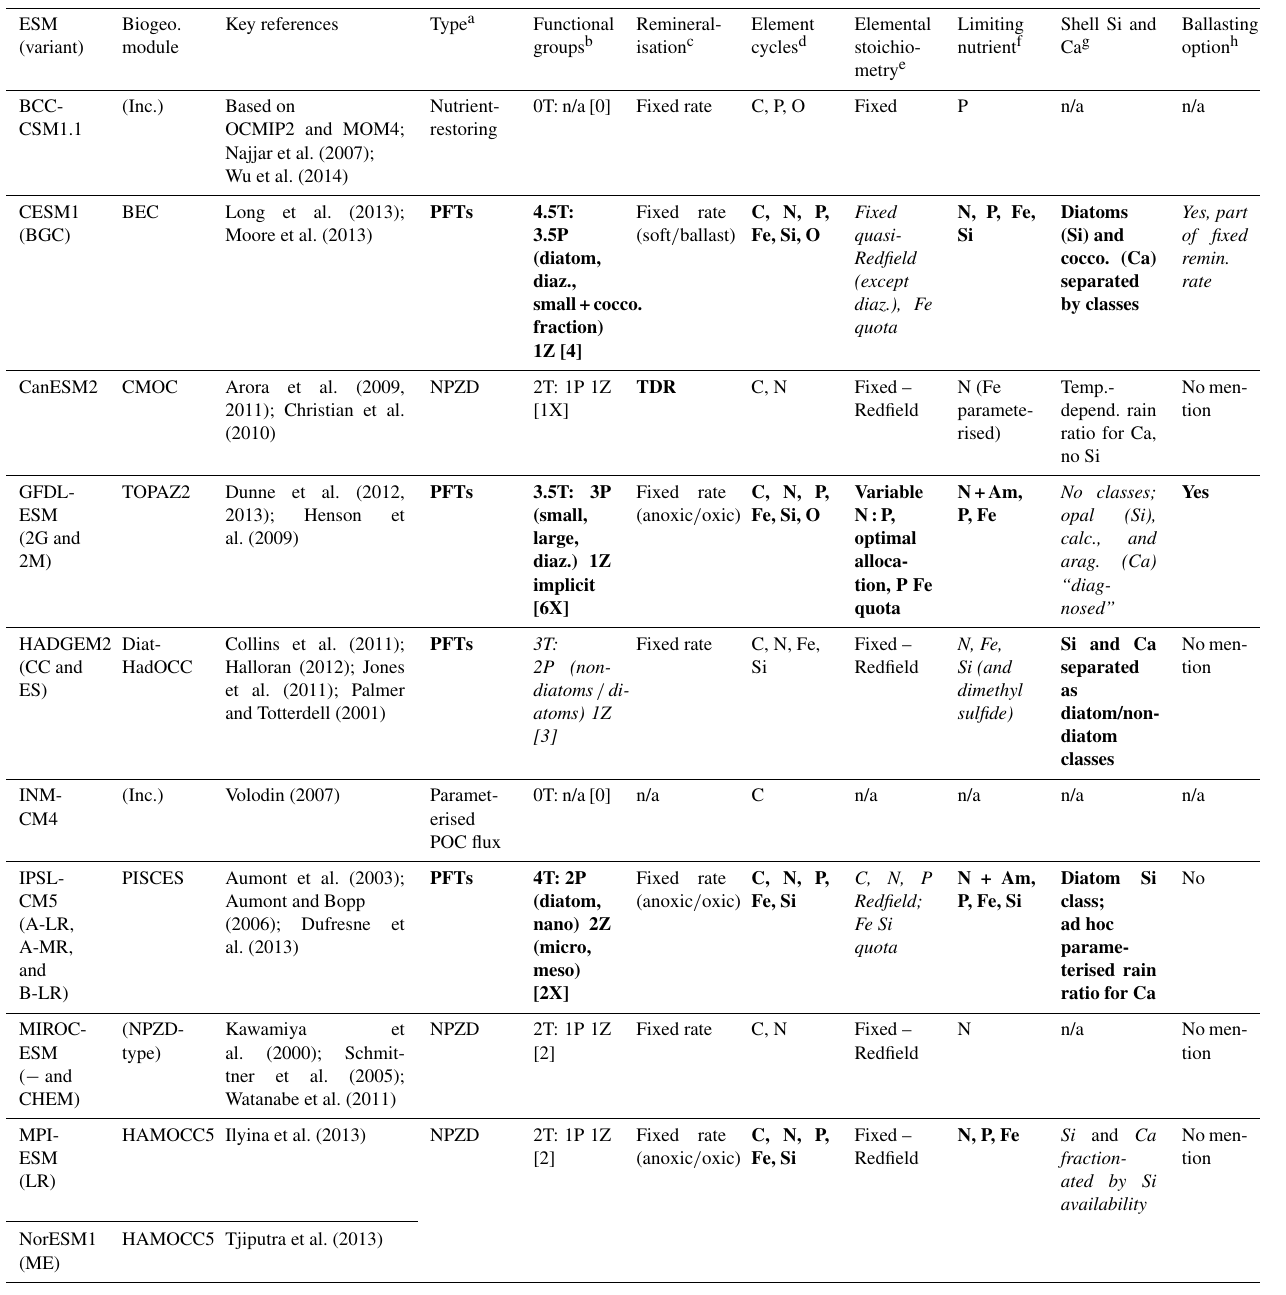
Table 1. Features critical for resolving biological pump dynamics of CMIP5 ESMs used to simulate ocean carbon sink projections in IPCC AR5. Details are based on IPCC AR5 WG1 Tables 6.11 (Ciais et al., 2013), 9.A.1 (Flato et al., 2013), and cited literature. Note that there are some mismatches between number of functional groups reported in the literature and the IPCC description. Highlighted cells indicate the models with the most (bold font) or moderately (italic font) comprehensive – but not necessarily sufficient – representation of the relevant model feature. “Biogeo.” refers to biogeochemical module, and “Inc.” refers to inclusive (i.e. the ESM does not have a specific biogeochemical module, with biogeochemistry implicit in the ocean module